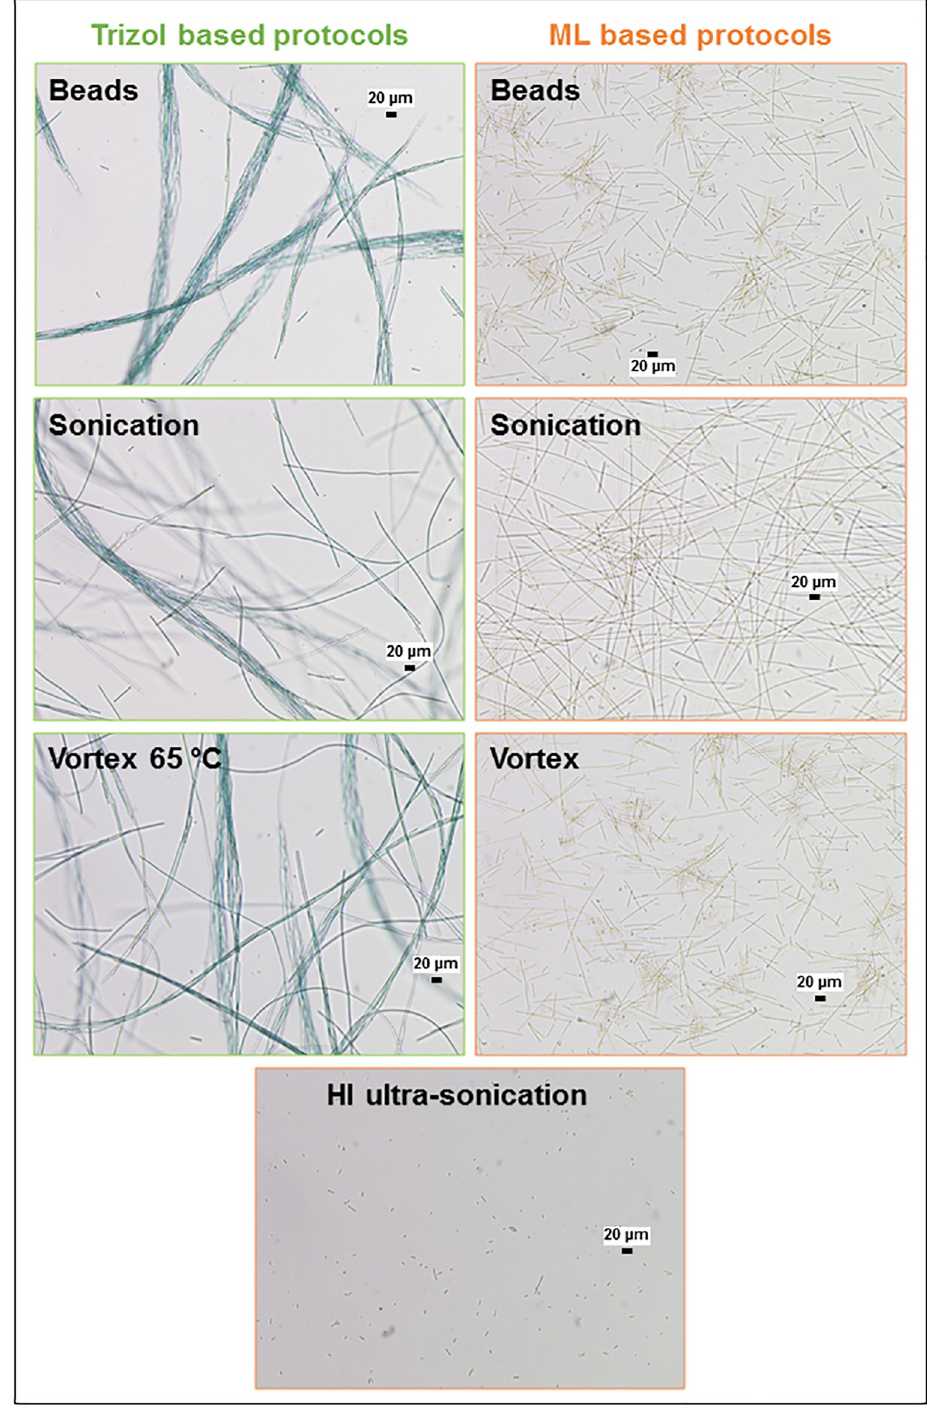
Fig 2. Microscopic observations (n = 2) of P . agardhii after “Beads,” “Sonication,” “Vortex 65,” and “HI ultra- sonication” RNA extraction protocols realized in Trizol or Lysis buffer ML.